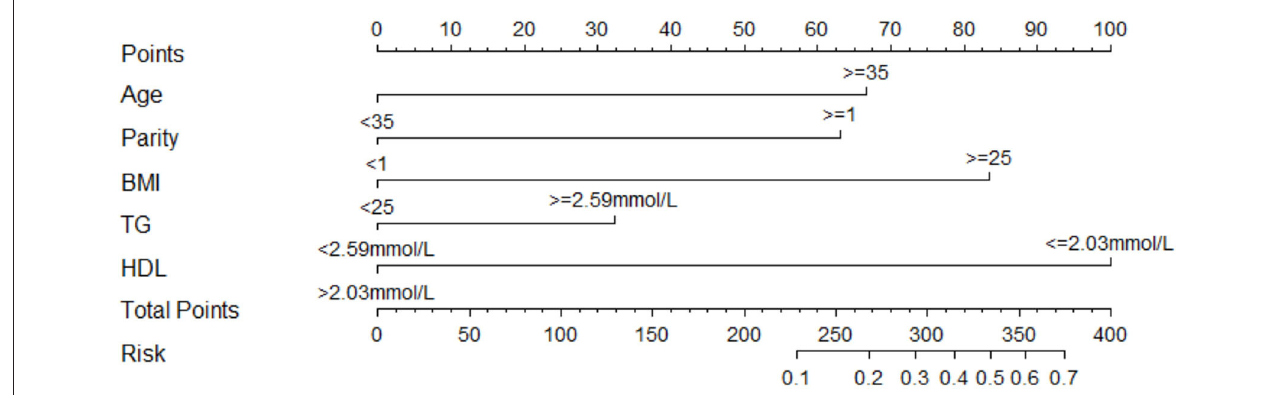
FIGURE 4 | Nomogram to predict the probability of early-onset PE. Instructions to use the nomogram are as follows: (1) to obtain the nomogram-predicted probability, locate patient values on each axis; (2) draw a vertical line to the point axis to determine how many points are attributed for each variable value; (3) sum the points for all variables; (4) locate the sum on the total point line to assess the early-onset PE probability at the lower line of the